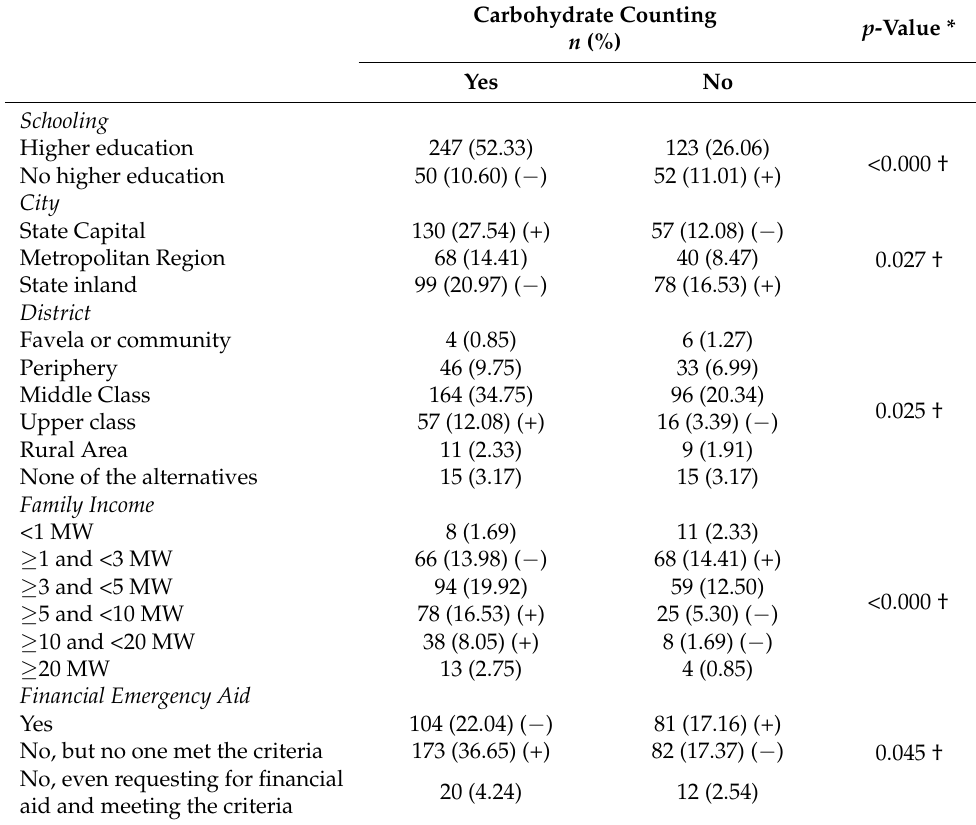
Table 1. Association between CC execution and sociodemographic and economic data of people with T1DM during social distancing in Brazil, July 2020. Carbohydrate